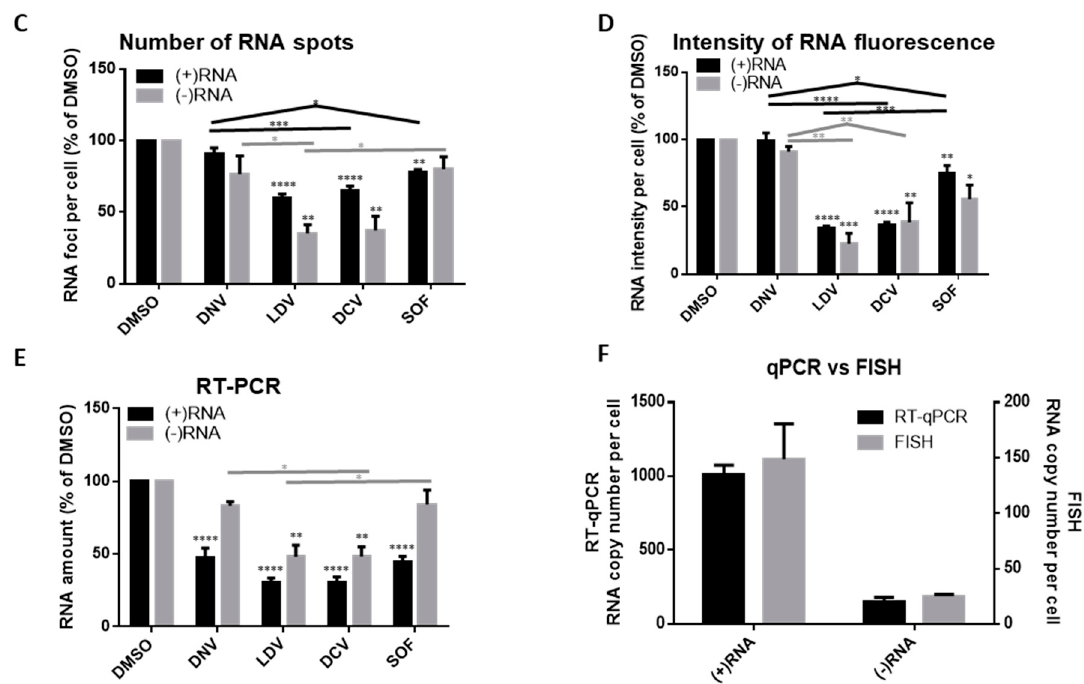
Figure 5. Early impact of different classes of HCV inhibitors on HCV RNA and NS5A. ( A ) Huh-7.5.1 cells were infected with HCV Jc1/Gluc2A at an MOI of 0.5. After 48 h, the cells were treated with various inhibitors (Danoprevir, 0.32 µM; Ledipasvir, 3 µM; Daclatasvir, 3.2 nM; Sofosbuvir, 20 µM), then after a further 8 h cells were fixed and probed sequentially for ( − )RNA, (+)RNA and NS5A. Finally, nuclei were stained with DAPI. Cells were imaged on a Leica SP8 confocal microscope using a 63× oil-immersion objective. ( B ) Representative images from each inhibitor showing ( − )RNA in green, (+)RNA in red, NS5A in gray and nuclei in blue. Boxed regions shown enlarged. Scale bars represent 10 µm. Early impact of different classes of HCV inhibitors on HCV RNA and NS5A. (C and D) Fields of view were captured as described in Figure 3, then analyzed using Gen5 software (BioTek). Abundance of (+) and ( − )RNA strands was quantified by: ( C ) number of RNA foci per cell; ( D ) RNA fluorescence intensity per cell in the field of view; and ( E ) RT-qPCR to determine copy numbers of the of (+) and ( − )RNA using specific primers. All values are expressed as a percentage of the DMSO-treated sample. Error bars indicate standard error of the mean for three independent experiments. Significance of differences between DMSO and drug treatments was calculated using one-way ANOVA and Tukey’s post-test for multiple comparisons. Differences were not significant unless otherwise indicated. *, p ≤ 0.05; **, p ≤ 0.01; ***, p ≤ 0.001; ****, p ≤ 0.0001. P values shown on columns indicate comparison to DMSO. Lines indicate comparisons between test samples. Lines group samples, and are color coordinated for (+)RNA and ( − )RNA. Flat lines group all samples beneath them, inverted Vs indicate comparison of the samples under the ends of the lines. DNV, Danoprevir; LDV, Ledipasvir; DCV, Daclatasvir; SOF, Sofosbuvir. ( F ) Comparison of intracellular HCV transcript number under control (DMSO) conditions as determined by strand-specific RT-qPCR and bDNA FISH. Error bars indicate standard error of the mean; no additional statistical analyses were performed.